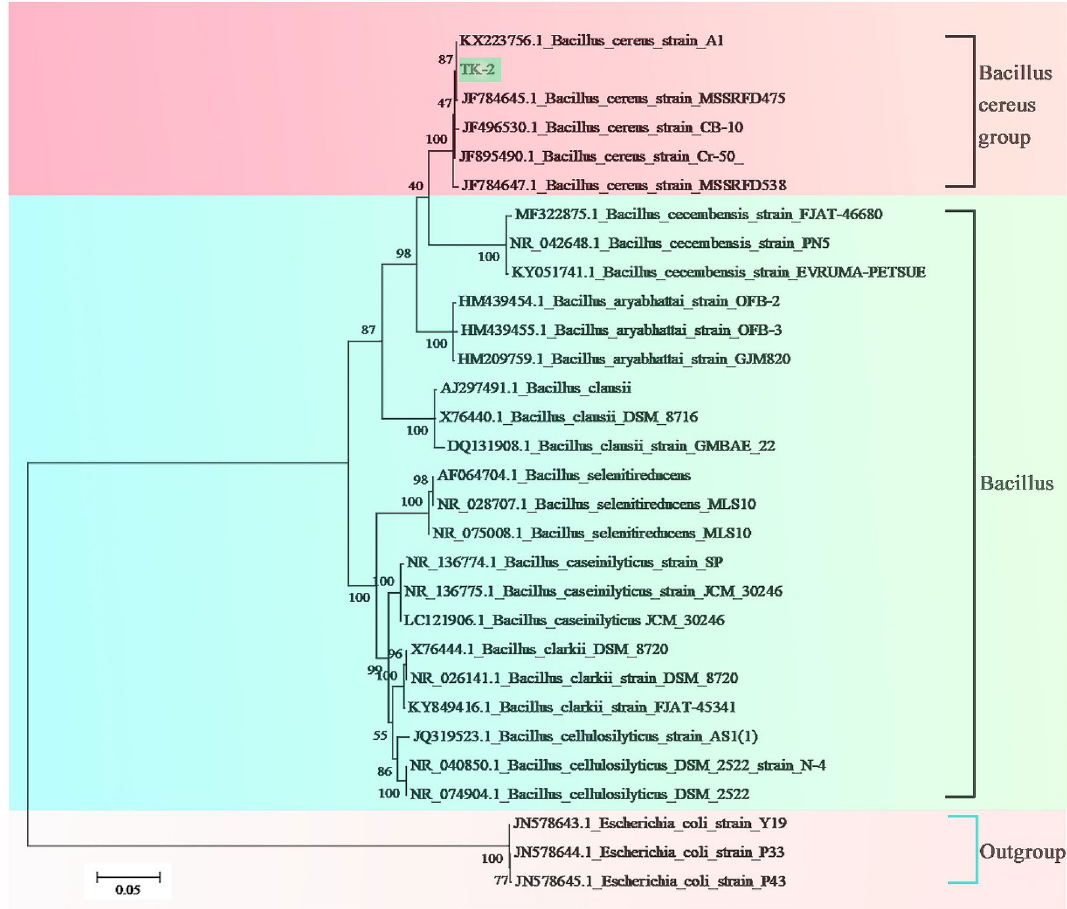
Figure. 5. ML phylogenetic tree reconstruction containing the 16S rDNA genomes of 30 strains of bacteria. Escherichia coli was set as the outgroup.